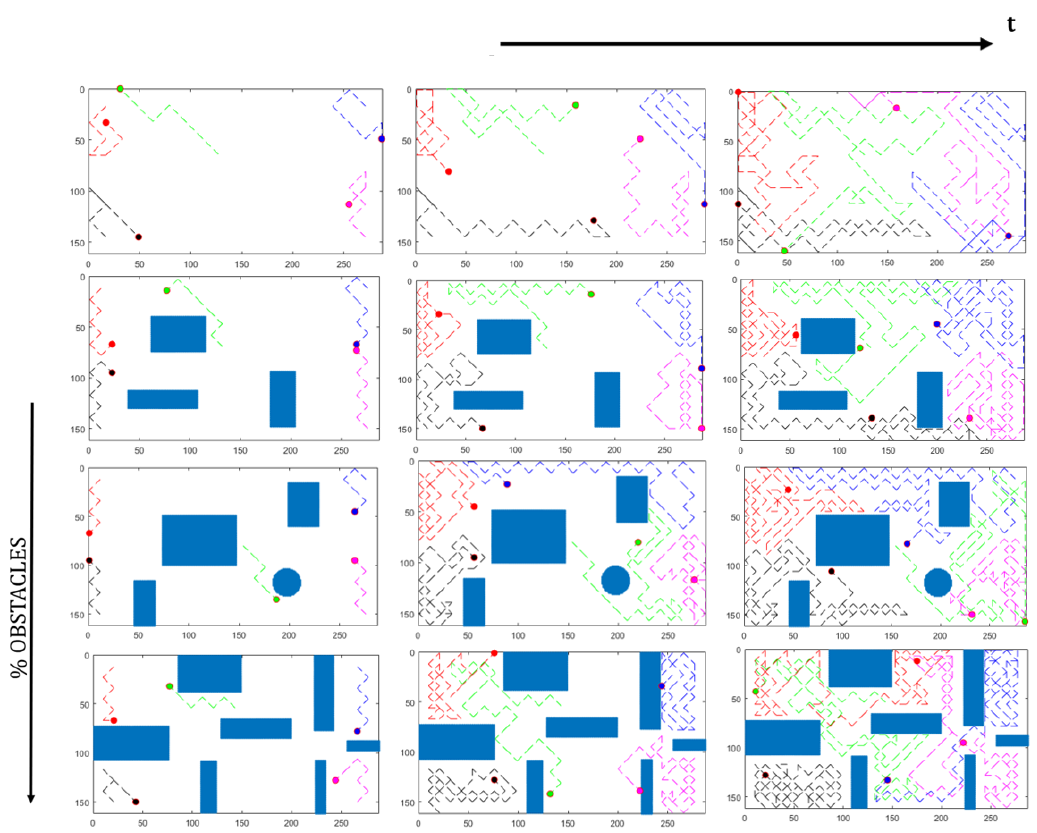
Figure 6. Temporal evolution of the fleet performing the coverage task with five UAVs. From the top, the complexity of maps is increased incrementally.